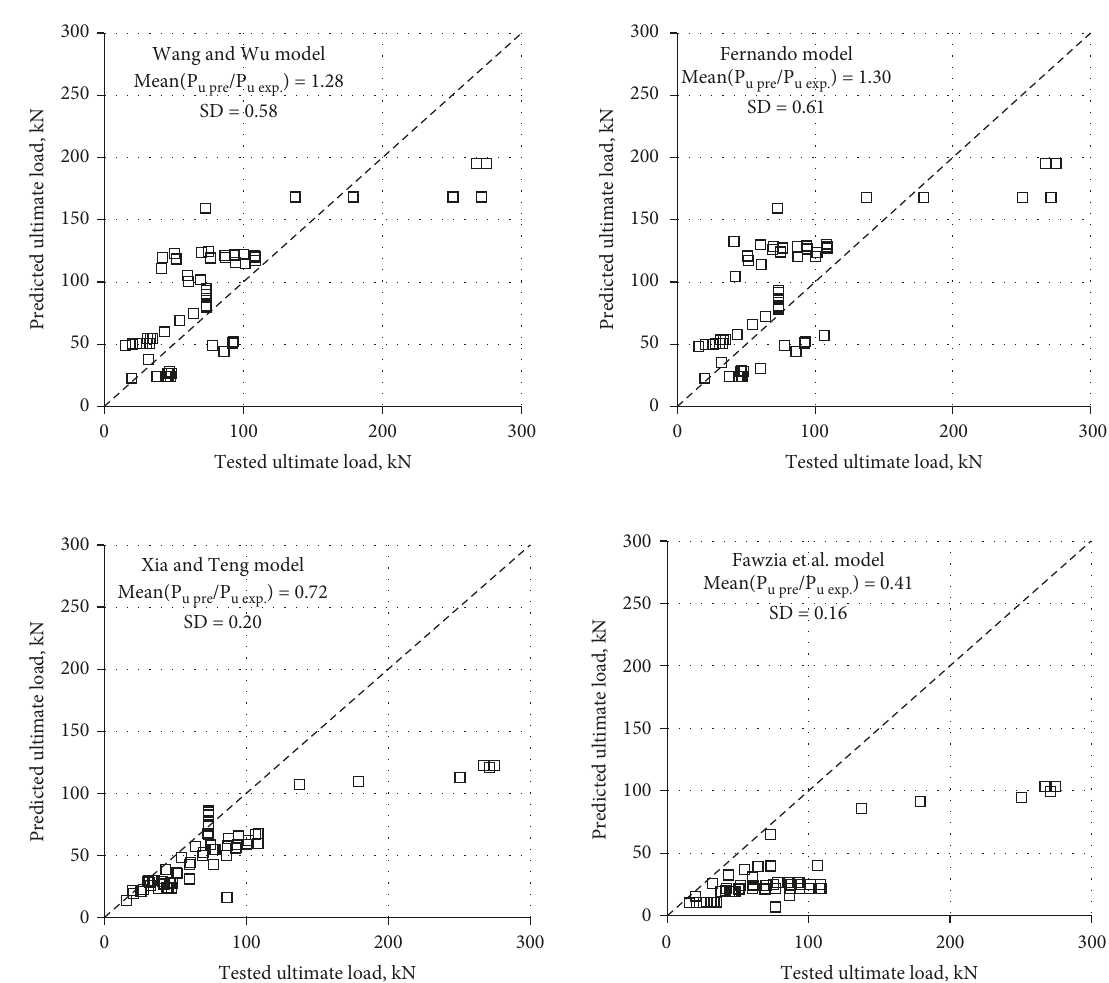
Figure 4: Comparisons of predicted vs. experimental ultimate load (Pu), evaluating existing τ –s